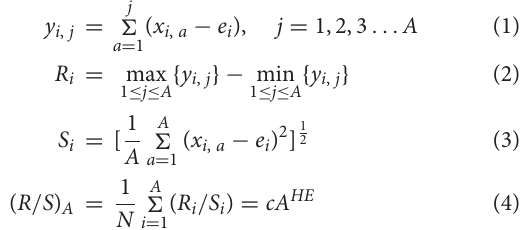
Frontiers in Neuroscience |